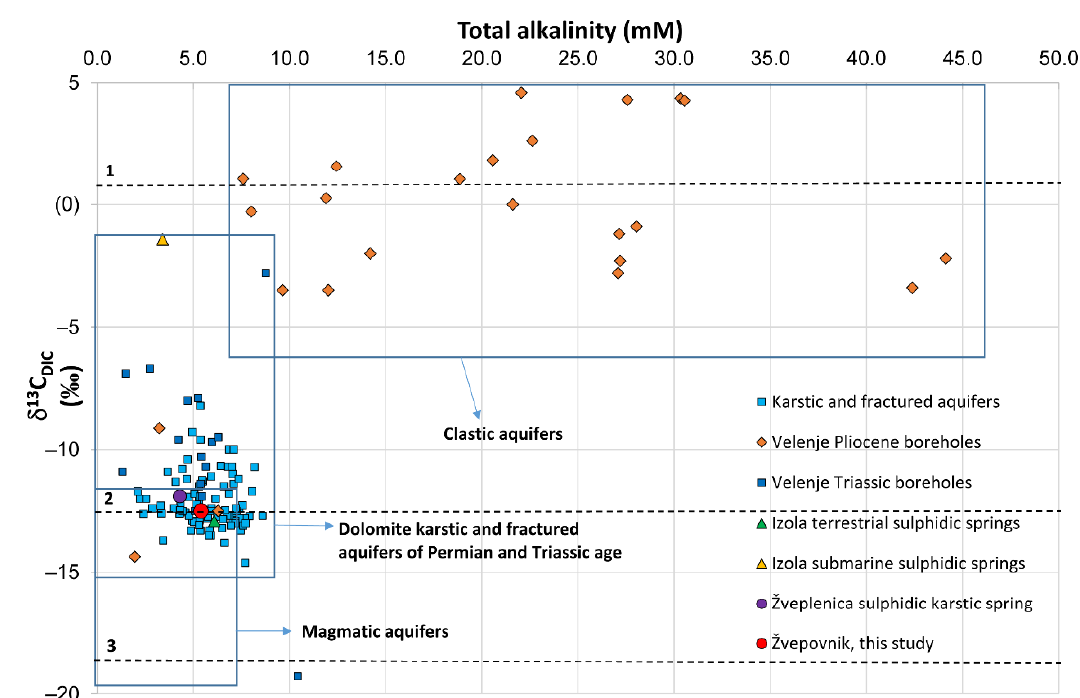
Figure 7. δ 13 C DIC versus alkalinity in Žvepovnik, Savinja valley, with lines indicating biogeochemical processes with a comparison of δ 13 C DIC versus total alkalinity of spring water from this and other studies: the Žveplenica sulphur karstic spring [8], tap water from central Slovenia [62], mining groundwater wells (Pliocene and Triassic) from Slovenia [63], and the Izola submarine and terrestrial sulphur springs [9]. See text for explanation of dotted lines 1, 2, and 3.